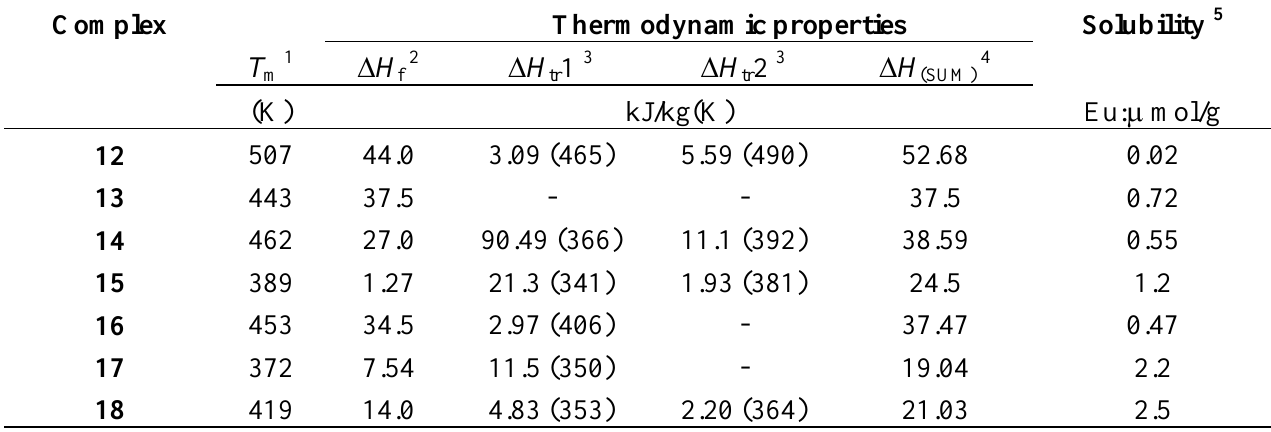
Table 2. The solubilities, melting points, and thermodynamic properties of Eu(III) complexes with  -diketonates and phosphine